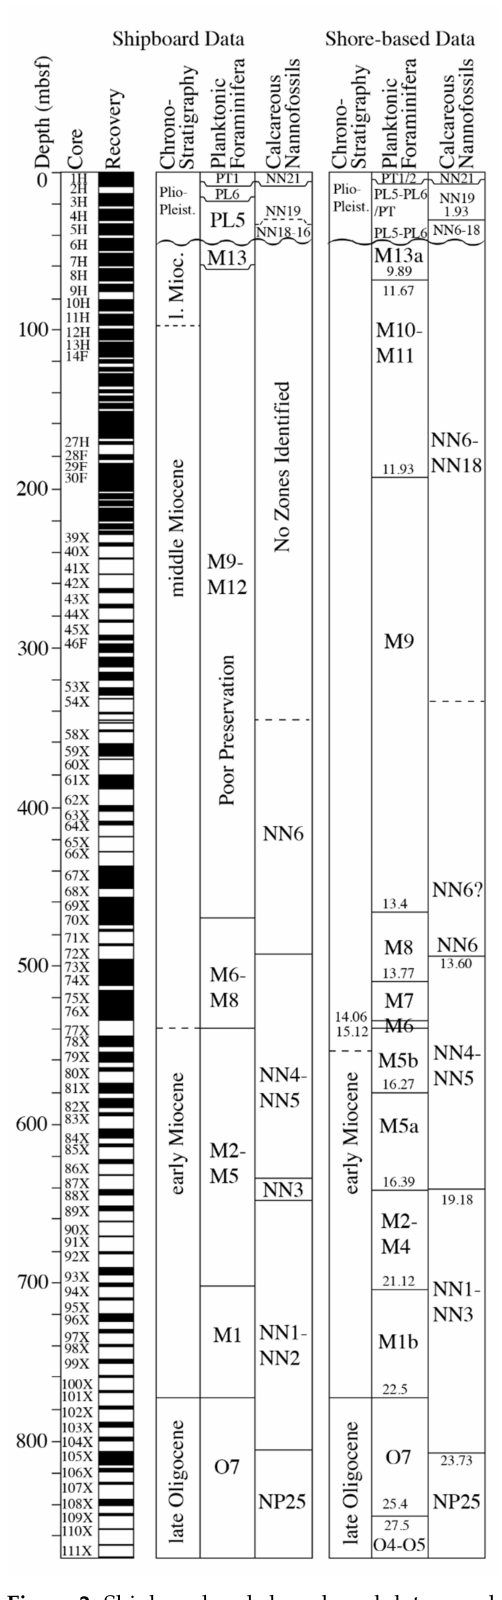
Figure 2. Shipboard and shore-based data correlation of planktonic and benthic foraminifera and Nannofossils Zonations are of [19–21], as modified by [22]. Ages (Ma) used in this shore-based study are from